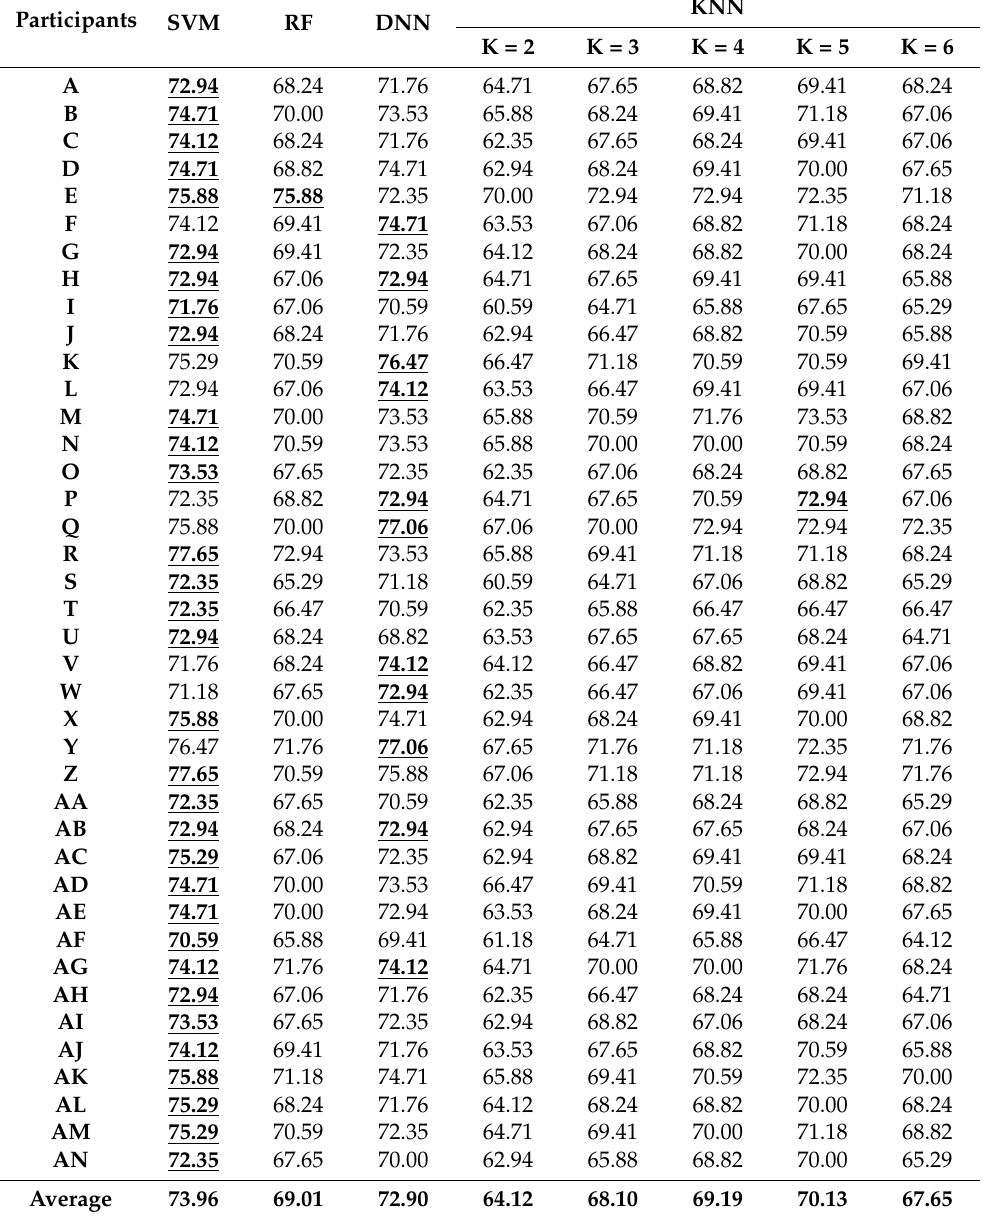
Table 5. Comparative analysis for emotion match rate with classification